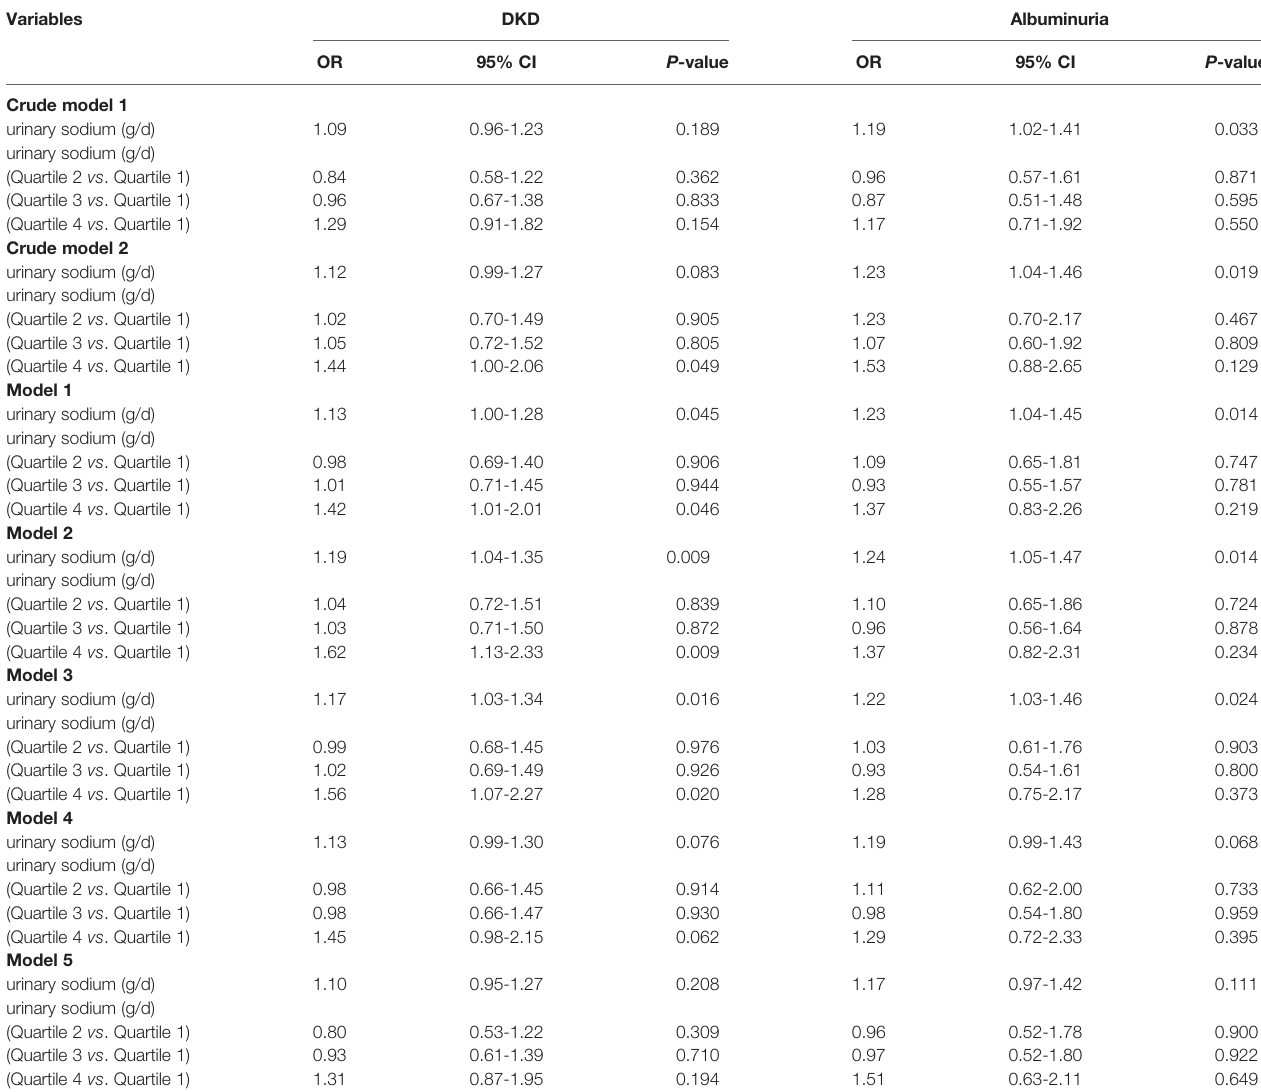
TABLE 4 | Odds ratios (ORs) of DKD and albuminuria according to urinary sodium excretion levels. Variables DKD Albuminuria OR 95% CI P -value OR 95% CI P